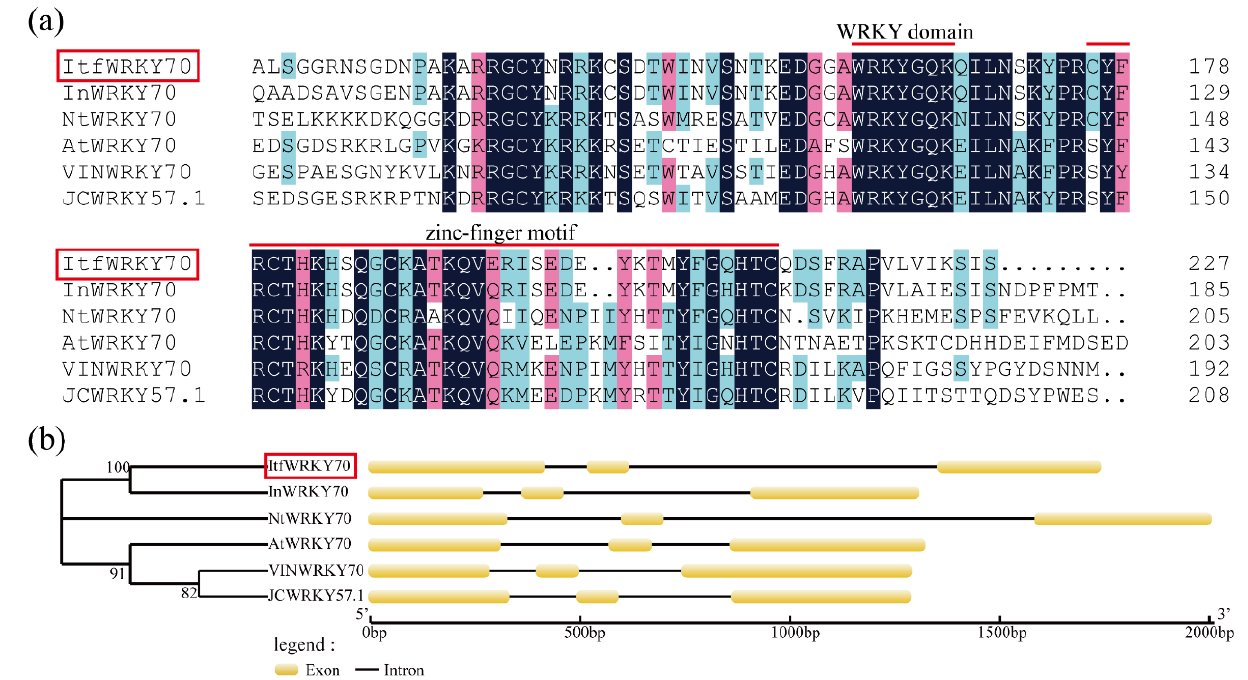
Figure 1. Sequence analysis of ItfWRKY70. ( a ) Multiple sequence alignment of the ItfWRKY70 protein and its closest homologs from different plant species. The WRKY domain and zinc-finger motif are represented with red lines. ( b ) Genomic structures of ItfWRKY70 and its closest homologs from different plants species. Exons are represented by ellipses, and introns are represented by lines.